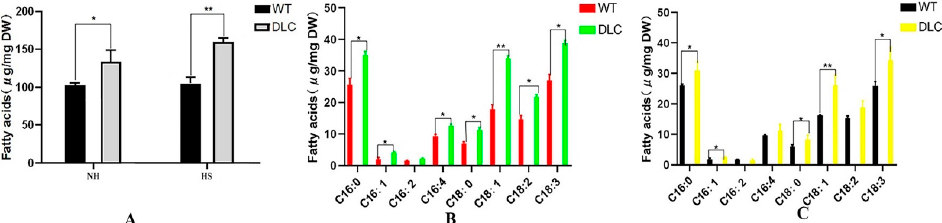
Figure 4. Total FA and lipid profiles in the DLC-4 and WT. ( A ) Total FAs of the DLC-4 and WT when strains were treated with HS (HS) and without HS (NH). ( B ) The profiles of the total lipids in the DLC-4 and WT when strains were treated with HS. ( C ) The profiles of the total lipids in the DLC-4 and WT when strains were treated without HS. Statistical significance (one-way ANOVA) is represented by asterisks (* and ** indicate a difference at p ≤ 0.05 and p ≤ 0.01, respectively). Error bars depict SD.